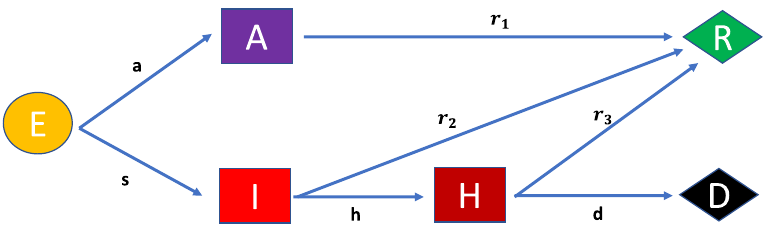
Figure 1. Flowchart of the populations considered in the model and the rates of transformation between them. The corresponding dynamical equations are Eqs.